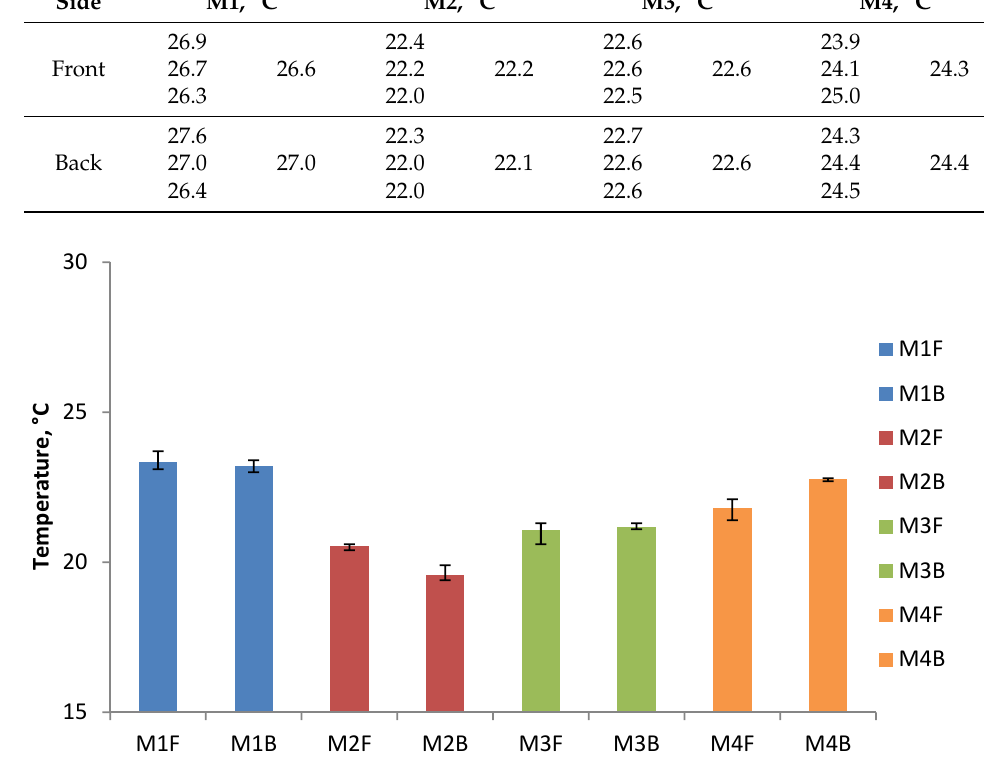
Figure 9. The results of average minimum temperature measurements on the surface of briquettes after briquetting: F—front, B—back .